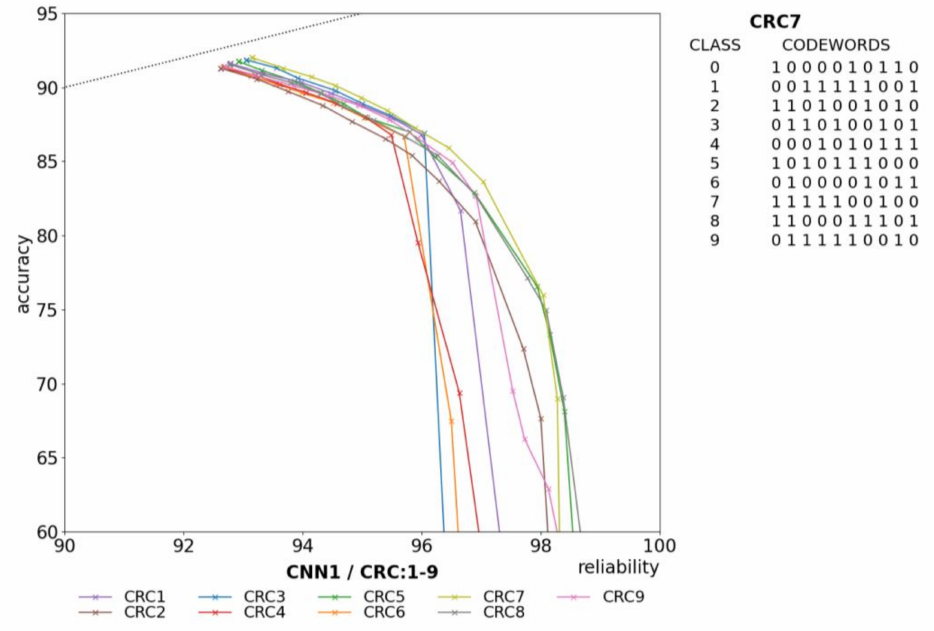
Figure 2. Accuracy–reliability characteristic for CRC codes (left), CRC7 class-codewords